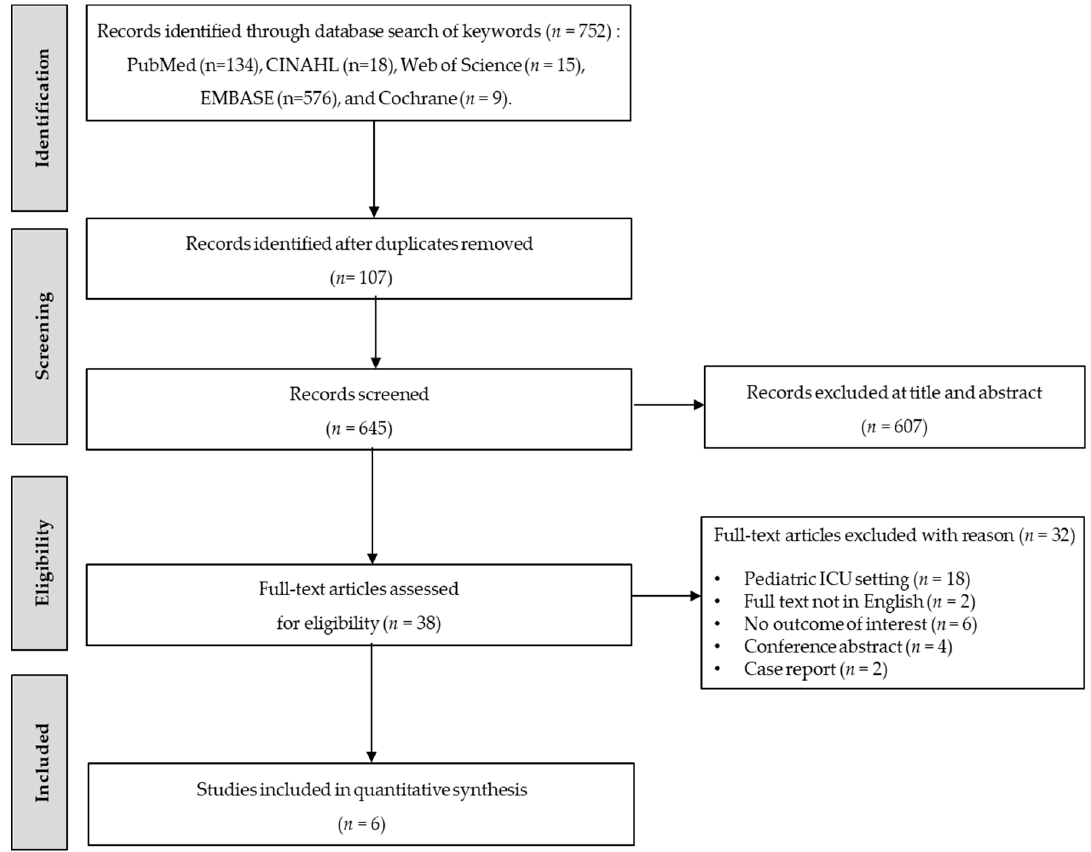
Figure 1. Flow diagram for study selection.